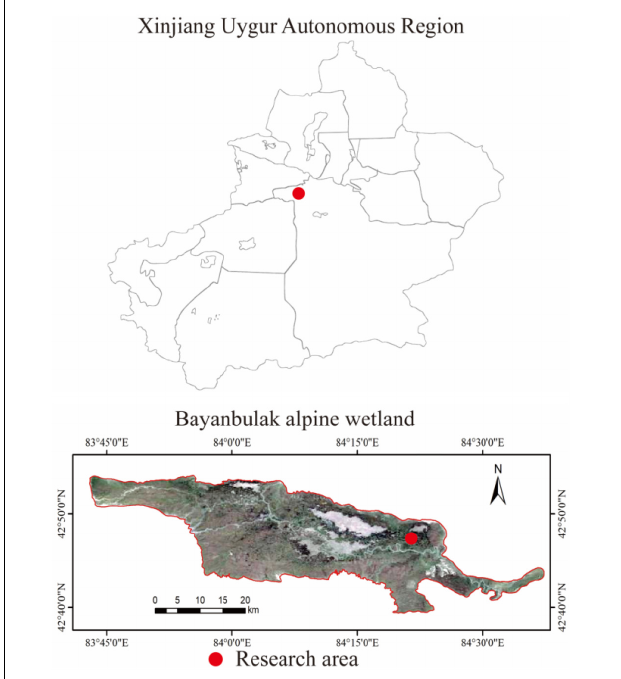
FIGURE 1 | Geographical location of the study